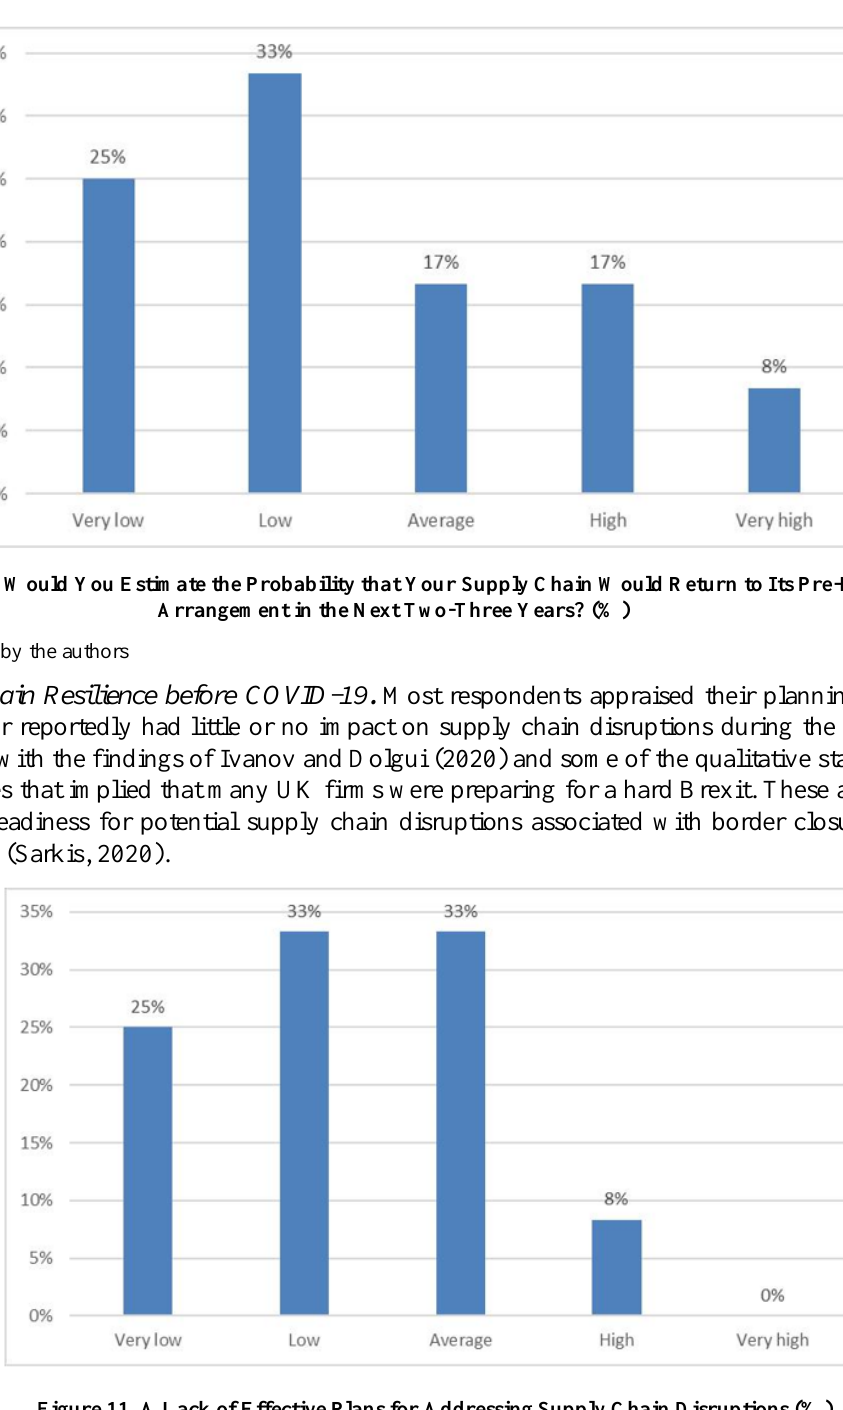
Figure 11. A Lack of Effective Plans for Addressing Supply Chain Disruptions